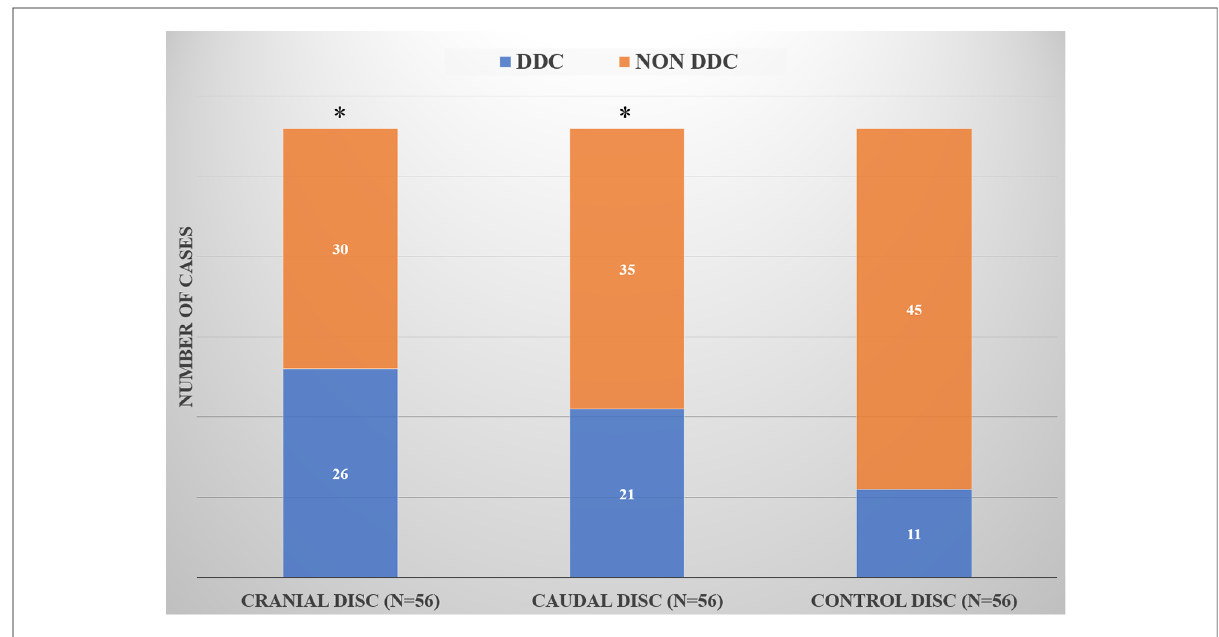
FIGURE 2 Comparison of DDC cases in the cranial, caudal and control groups. *Compared with the control group, there was a statistical difference.